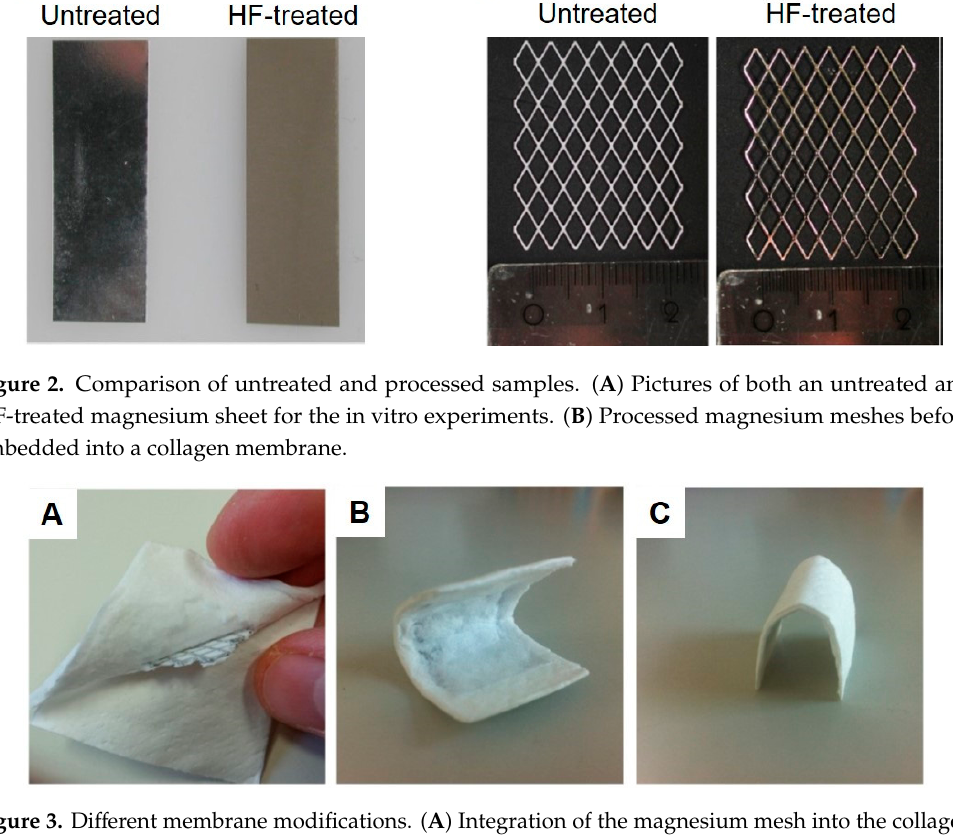
Figure 3. Different membrane modifications. ( A ) Integration of the magnesium mesh into the collagen fleece. ( B) and ( C ) Moldability and stability of the collagen membrane with an integrated Mg mesh.